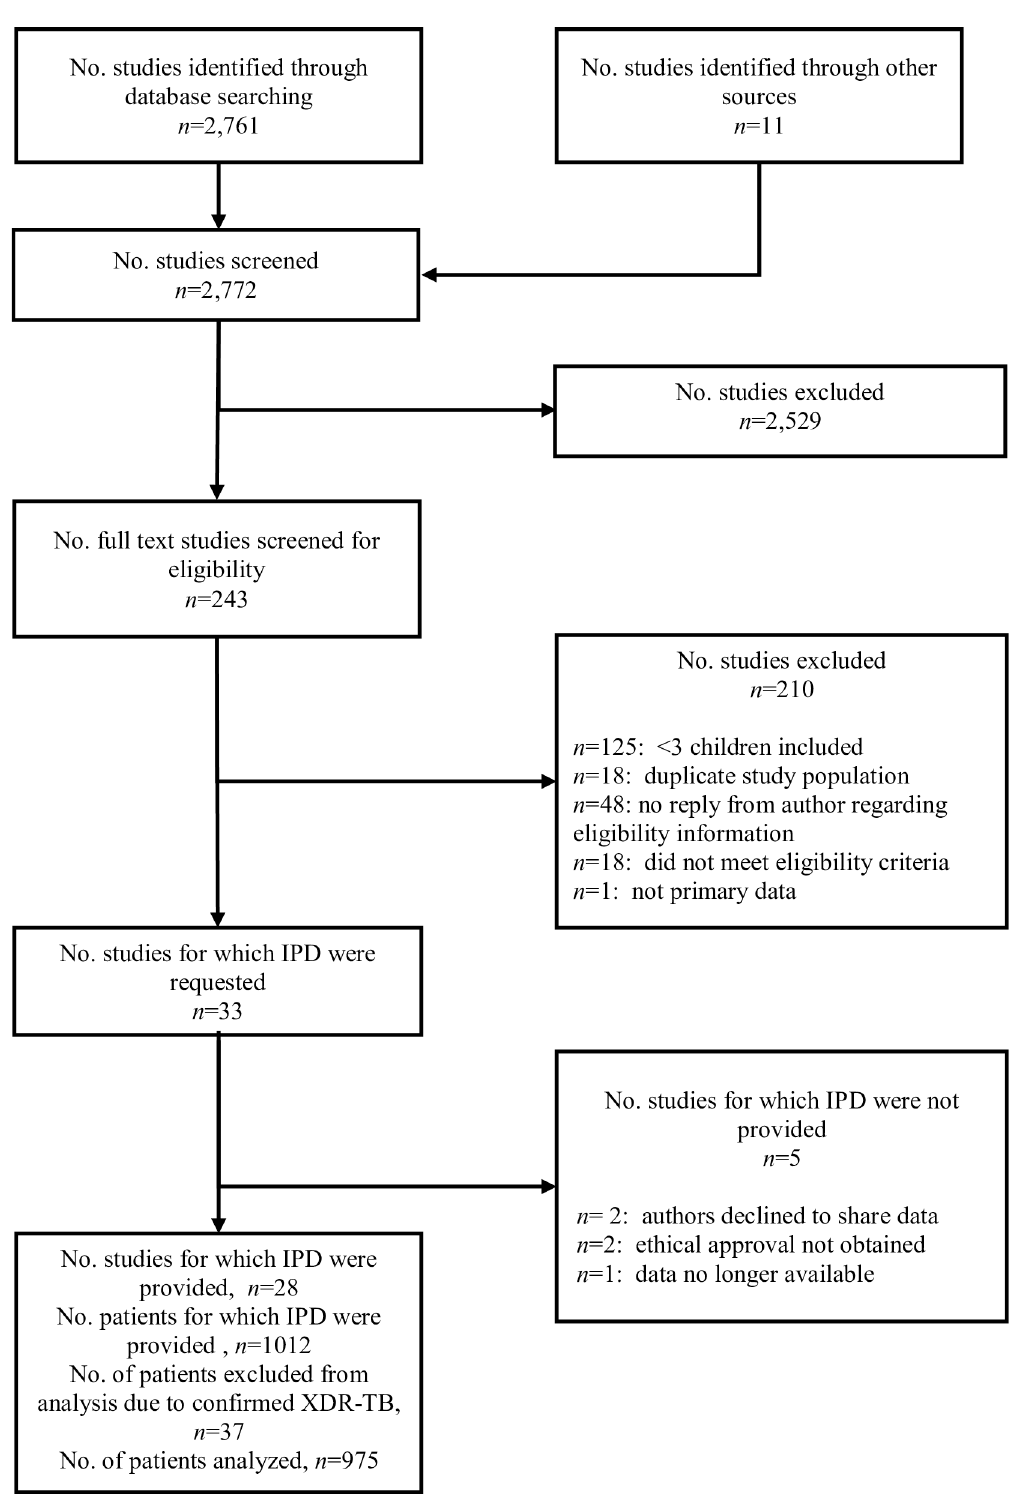
Fig 1. Study selection. IPD, individual patient data; XDR-TB, extensively drug resistant tuberculosis.